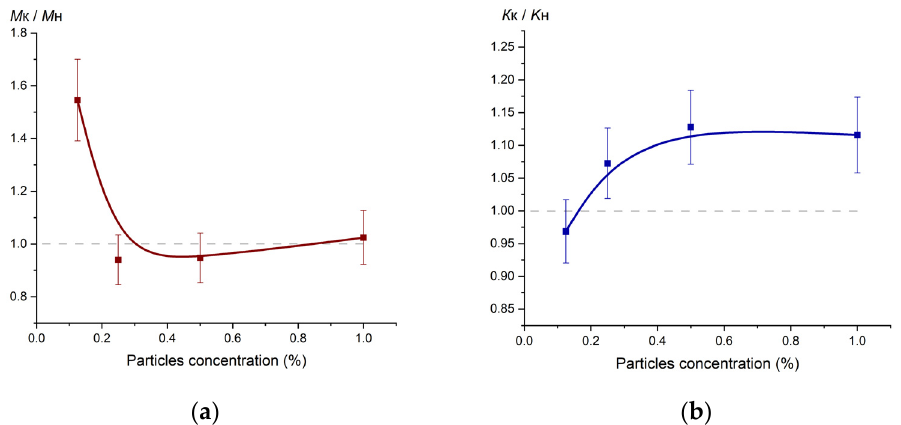
Figure 5. Optical performance of the polymer composite: ( a ) opacity vs particles concentration; ( b ) transmittance vs particles concentration.